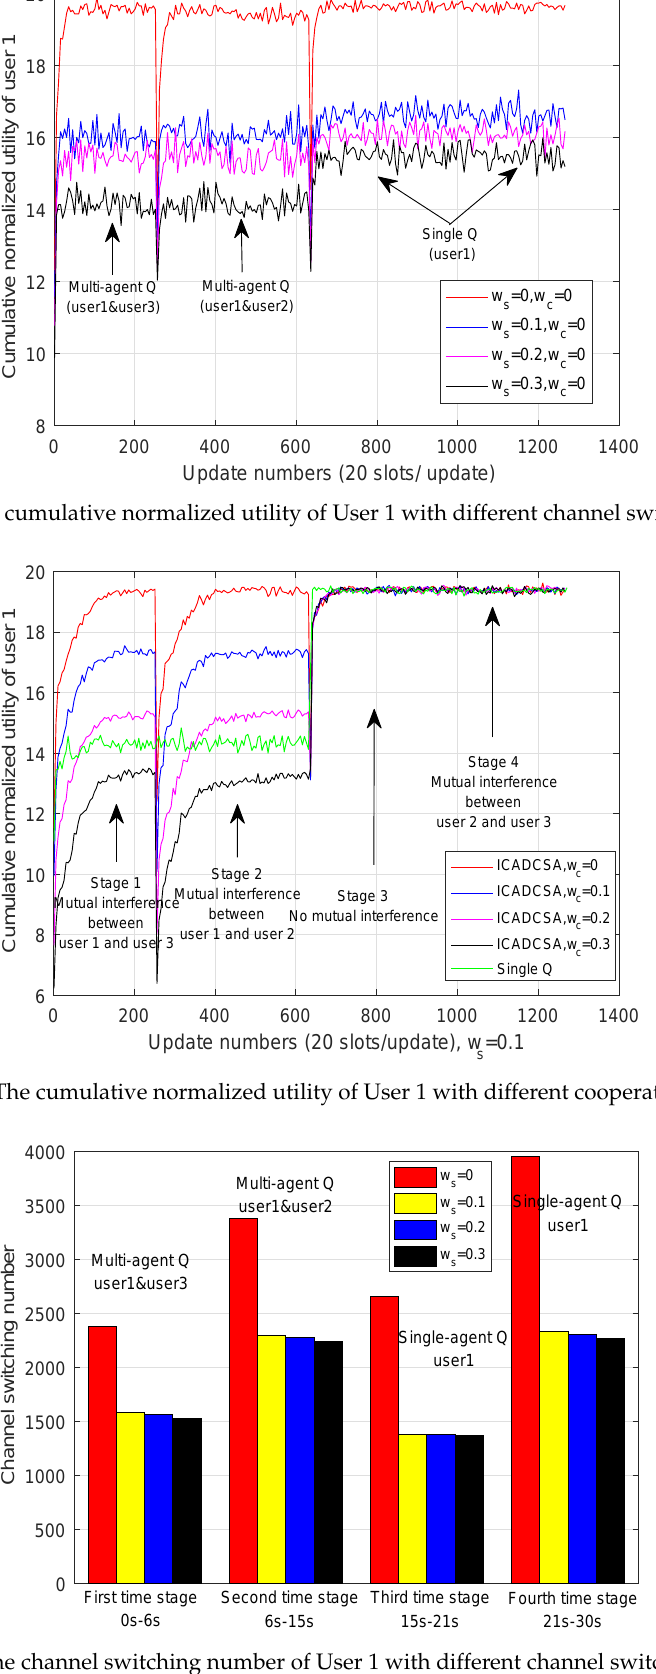
Figure 13. The channel switching number of User 1 with different channel switching